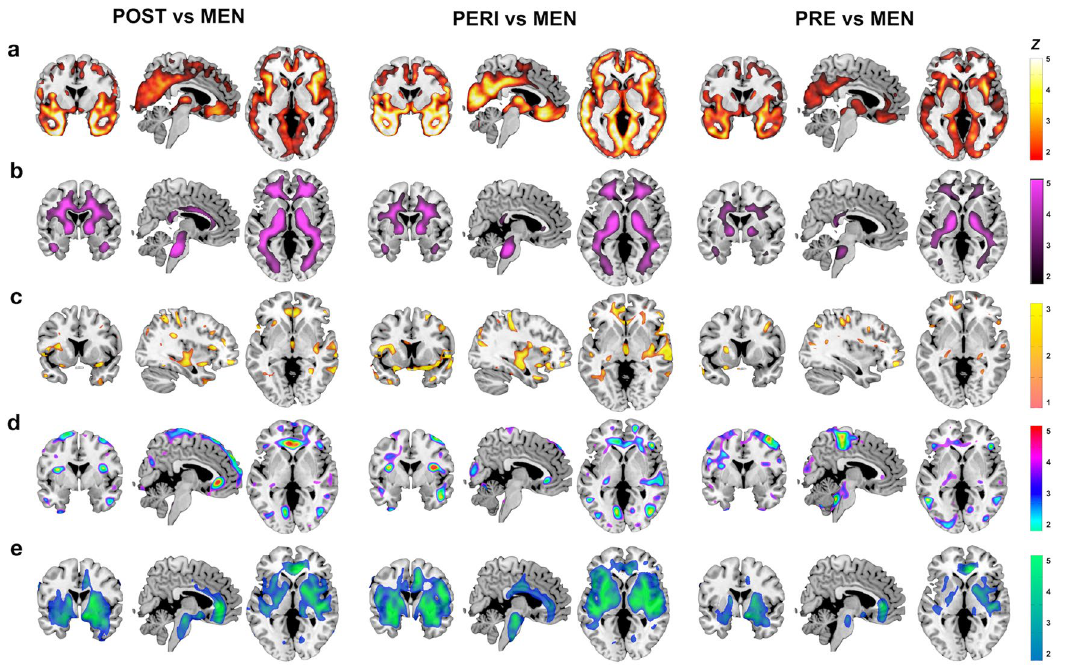
Figure 3. MRI slice overlays displaying biomarker differences between each MT group and males in the corresponding age ranges: ( a ) Lower GMV in (left) POST, (middle) PERI, and (right) PRE groups versus males. ( b ) Lower WMV in (left) POST, (middle) PERI, and (right) PRE groups versus males. ( c ) Higher FA in (left) POST, and (middle) PERI versus males; (right) no differences between PRE and males. ( d ) Lower CMRglc in (left) POST, (middle) PERI, and (right) PRE groups versus males. ( e ) Higher CBF in (left) POST, (middle) PERI, and (right) PRE groups versus males. ( f ) SPMs are represented on modality-specific color-coded scales with corresponding Z scores to enable multi-modality comparisons. Abbreviations See legend to Figs. 1 and